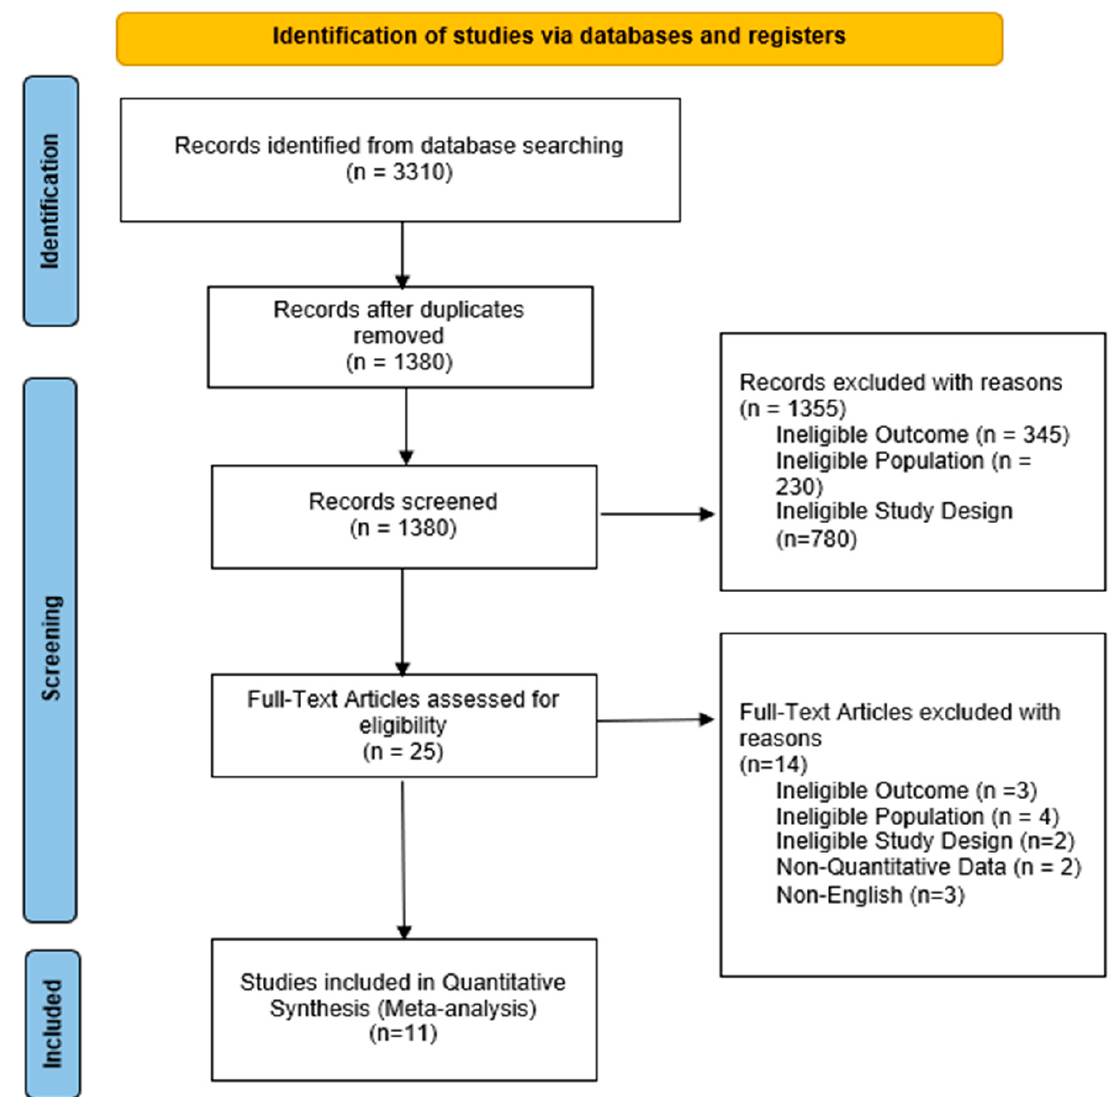
Figure 1. PRISMA Flowchart for Study Selection.